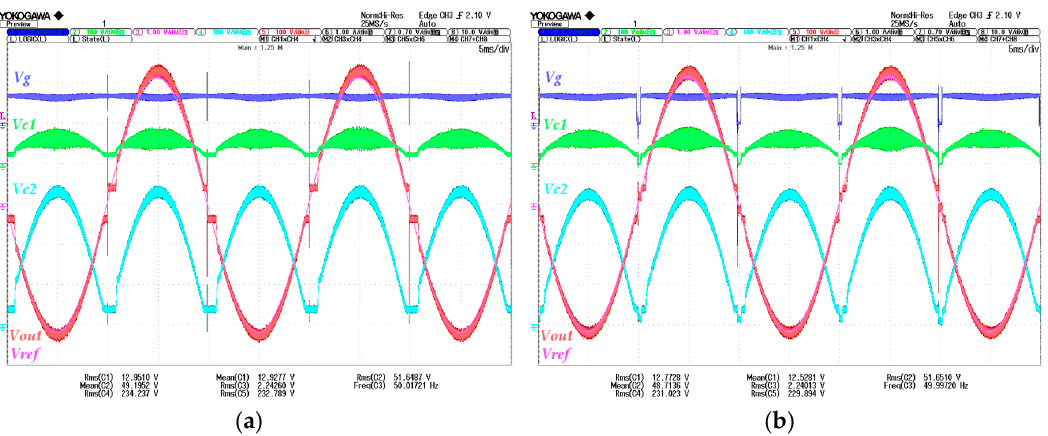
Figure 25. Input current surface with constant-width hysteresis. Microinverter variables traces, ( a ) without the Buck-switch, and ( b ) including the Buck-switch.